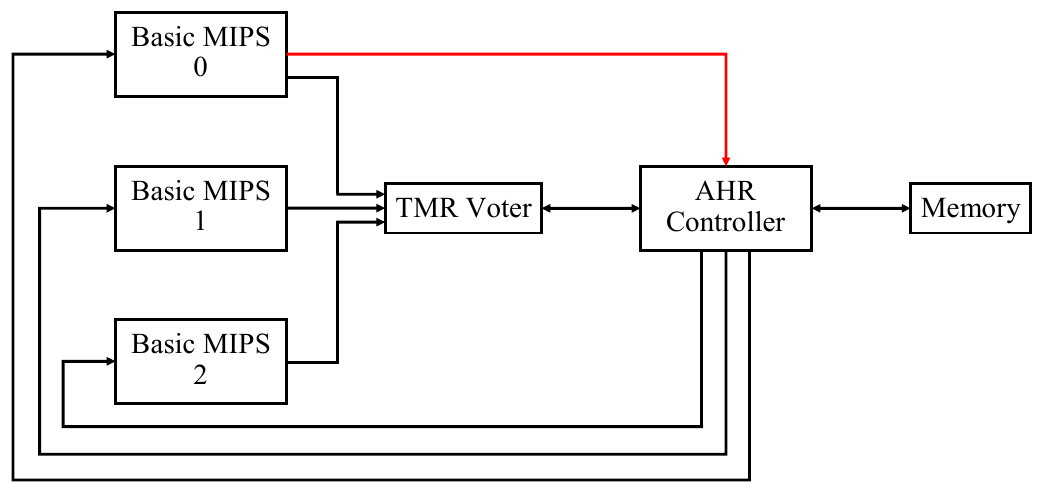
Figure 4. AHR MIPS in TMR mode simplified block diagram with disabled portions in red.